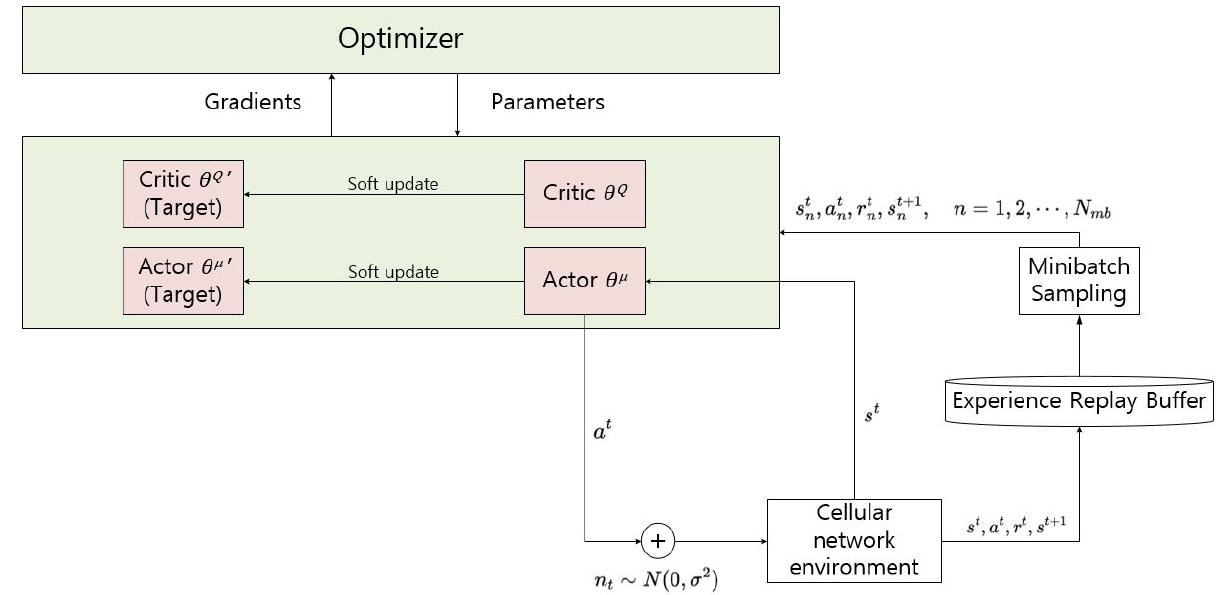
Figure 2. Illustration of the DDPG